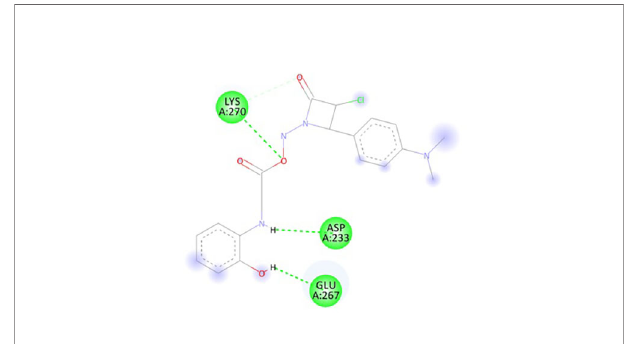
FIGURE 16 | 2D Interaction of ND5